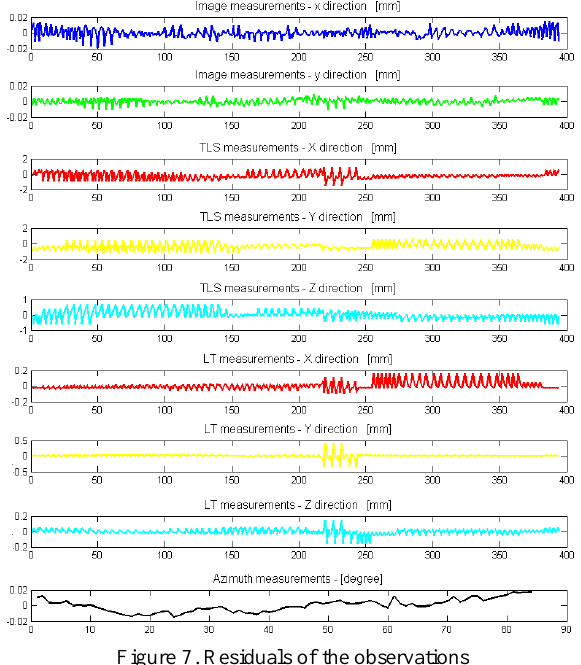
Figure 7. Residuals of the observations In figure 8, re-projection of the downsampled point clouds into the rectified image by the usage of calibration parameters is illustrated.